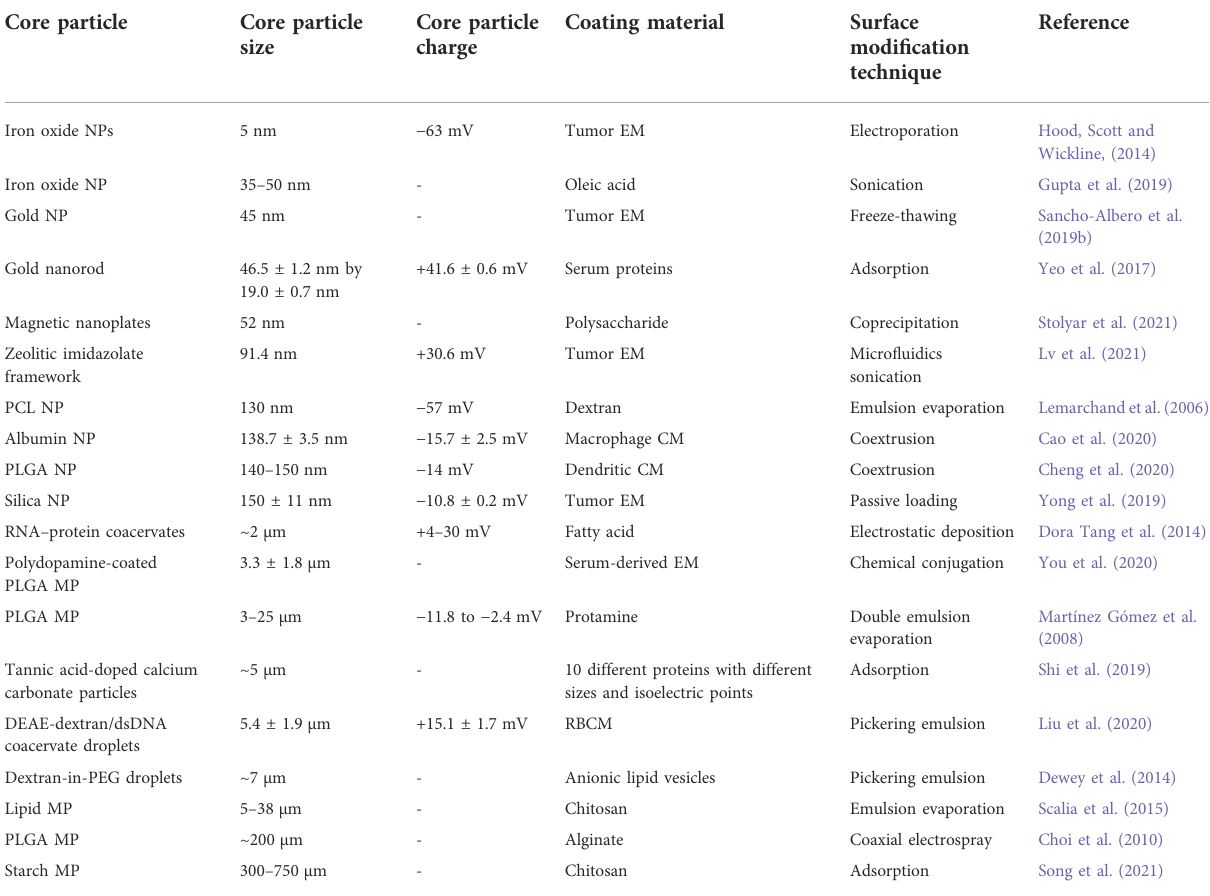
TABLE 7 Some examples of surface modi fi cation techniques of different type of core